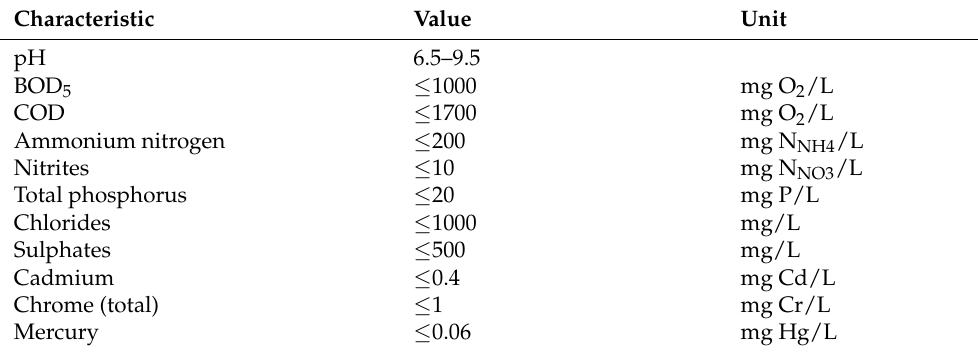
Table 2. Parameters of industrial wastewater specified in the integrated permit of the